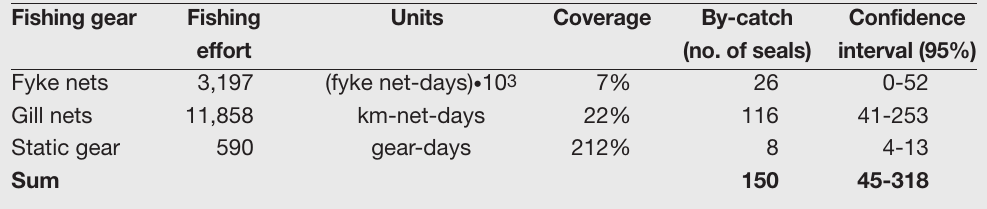
Table 3. Extrapolation of a yearly sum of by-caught harbour seals between 2001 and 2006 in commercial fisheries along the Swedish west coast, excluding trawls. The mean yearly fishing effort from both the official logbooks is multiplied with the calculated mean by- catch CPUE from the voluntary logbook during the same period (Table 2). The relation between the sum of effort from the voluntary logbook (between 2001 and 2006) and the mean yearly effort (from both the official logbooks) is shown as coverage. The 95% confi- dence interval is derived from a bootstrap calculation of the by-catch